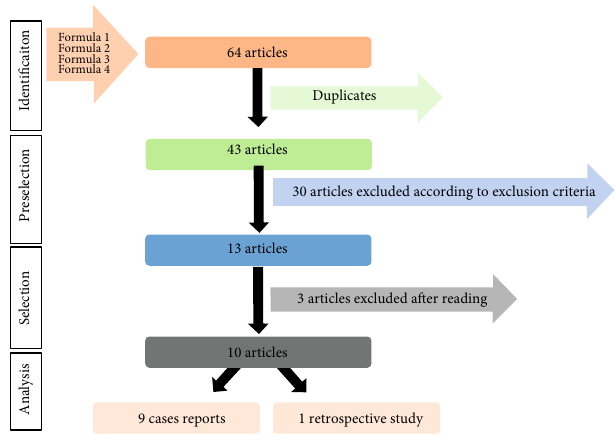
Figure 6: Articles